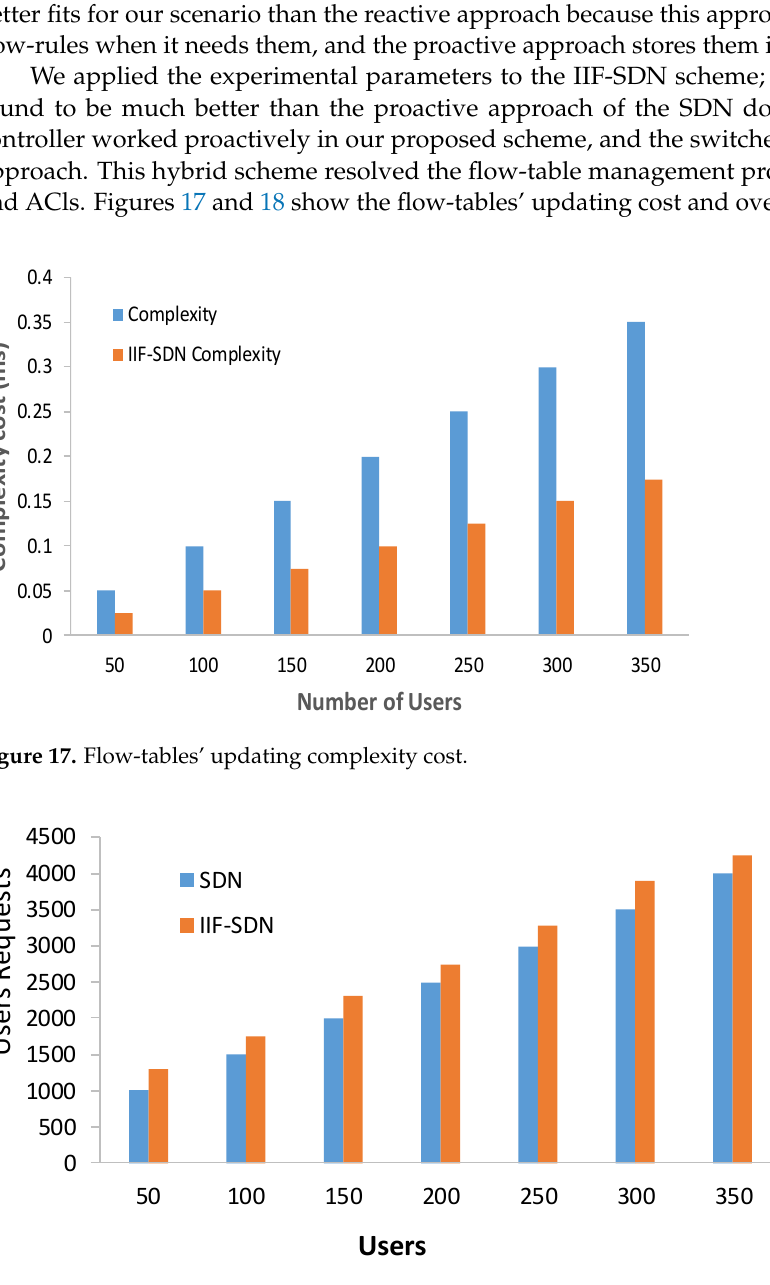
Figure 16. IIF-SDN (multiple nodes ’ flow-rule exchange).